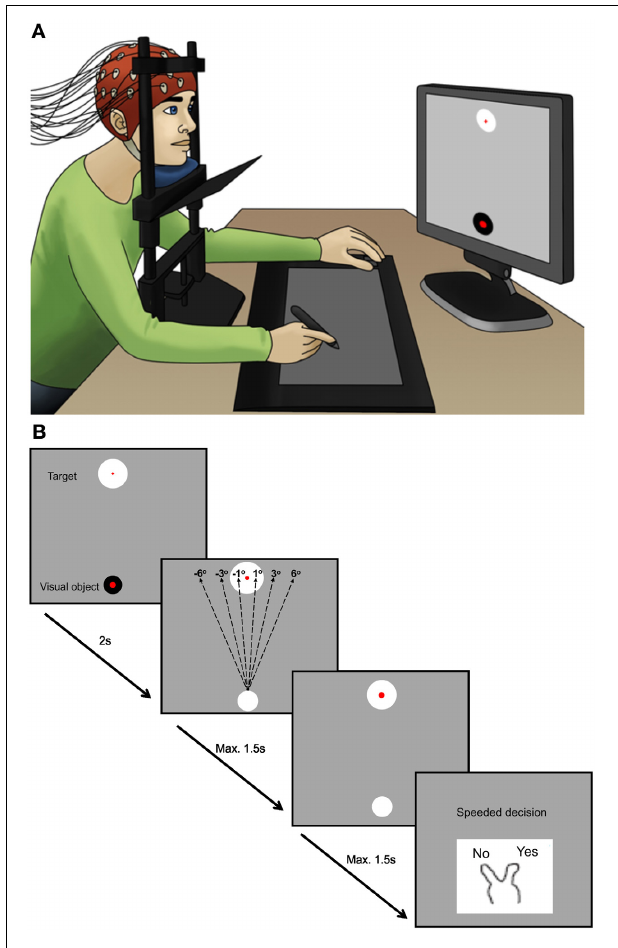
FIGURE 1 | The experimental design. (A) Displays the position of the participants during the experiment. The plate below the chin blocks the view of the hands but participants can follow the consequence of the action on the screen in front of them. (B) Illustrates what is occurring on the computer screen. During the experiment the cursor was randomly manipulated from the beginning of the movement by different angles of ( − 6, − 3, − 1, 1, 3, 6 ◦ ). Negative angles refer to manipulation to the left side of the target. Participants had max. 1.5s to perform the movement, but were instructed to move fast. When reaching the level of the target, the visual object disappeared and participants had to report as fast as possible (within 1.5s) whether or not they felt they were the agents of the observed movement by a key press of the index or middle finger of the left hand. After key press, participants had 2s to place the pen on top of the visual object and be ready for the next trial. During the experiment there were no lines visible on the display